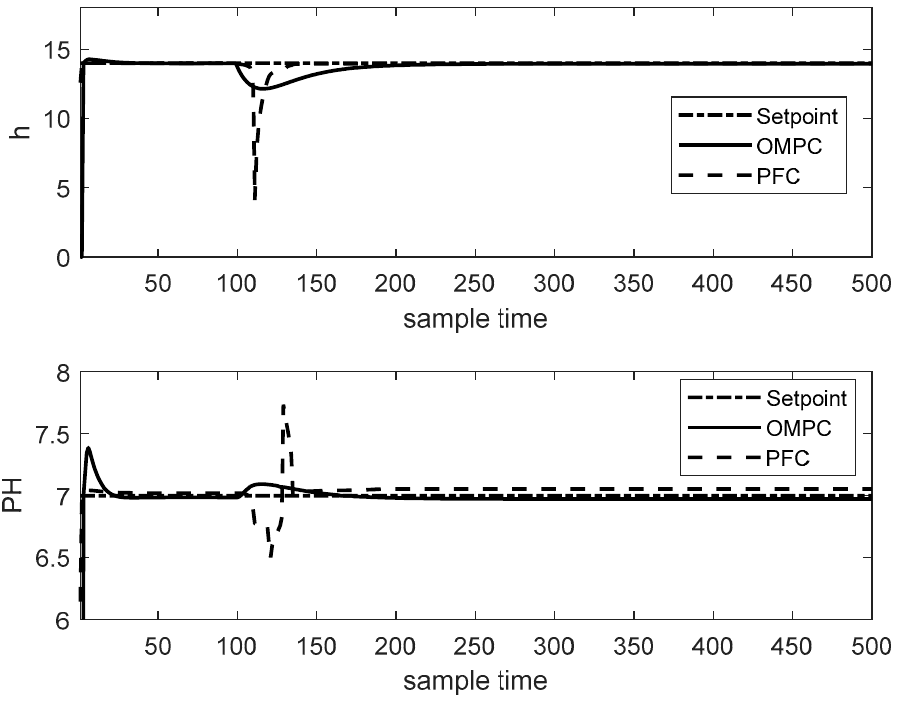
Figure 7. Results under the model disturbance.